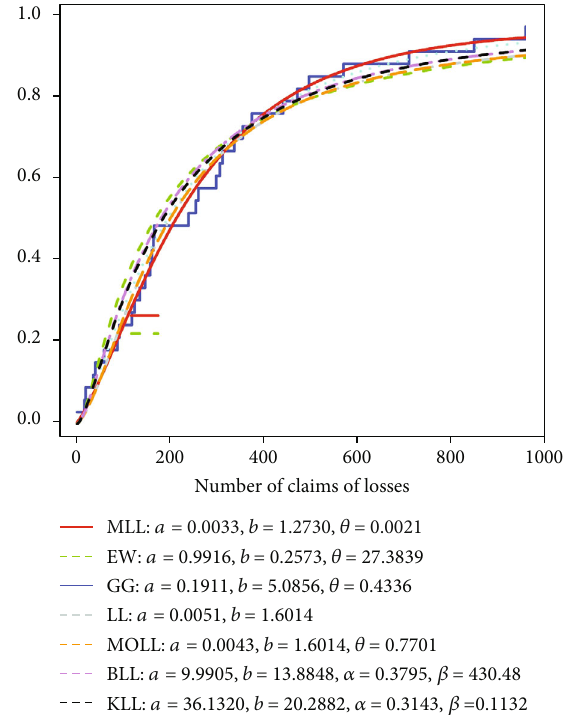
Figure 7: The empirical distribution function of loss data (Table 6) along with estimated